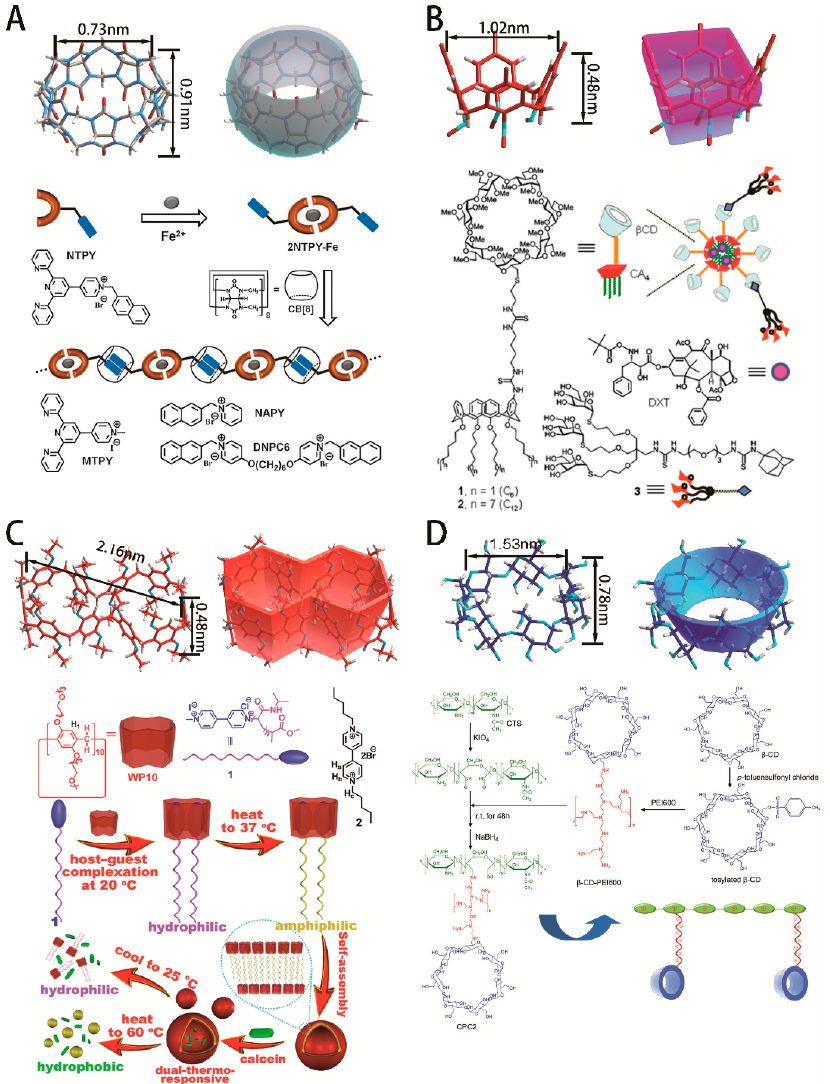
Figure 1. Macrocyclic compounds’ structures and applications: ( A ) Cucurbituril: Terpyridine-metal coordination to promote supramolecular polymerization and solubility employed by Zhang et al.